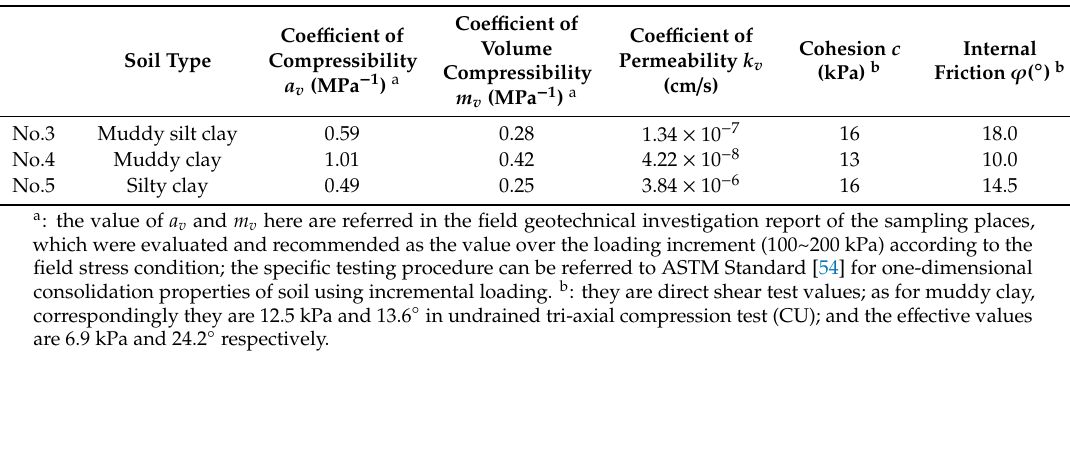
Table 3. Mechanical properties of the